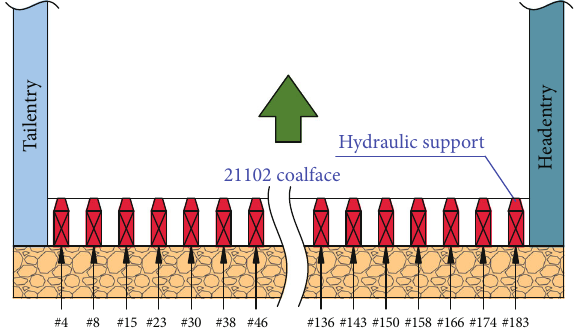
Figure 9: The layout of the measurement stations in the coalface.